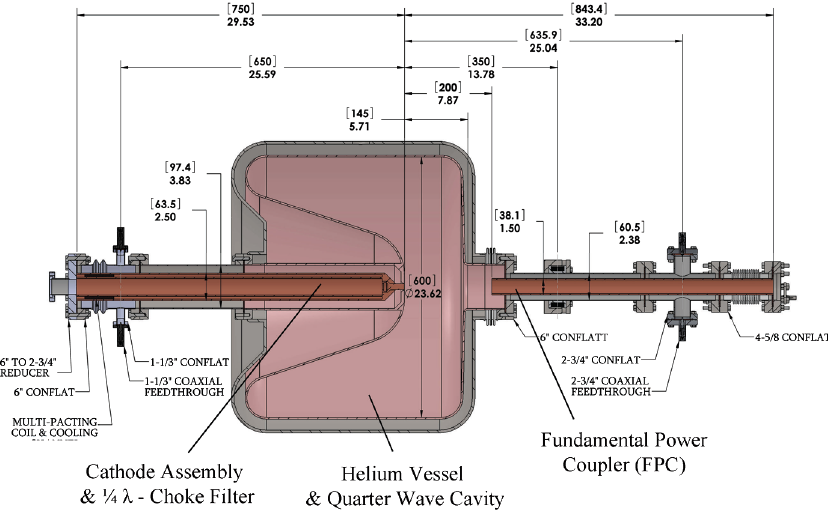
FIG. 14. 200 MHz—quarter wave Wisconsin University gun cavity. Courtesy of Terry Grimm, NIOWAVE Inc.